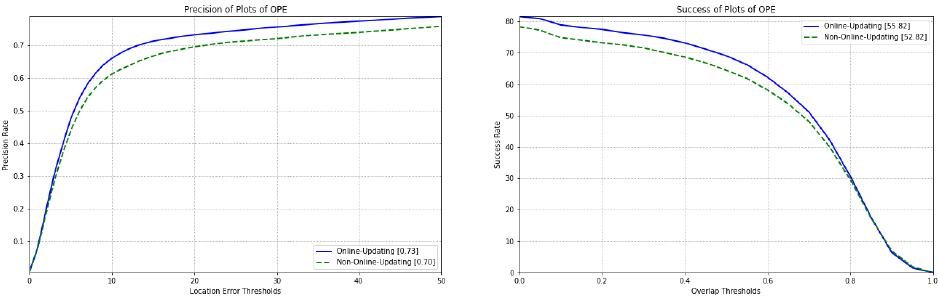
Figure 11. Success and precision plots on OTB2013 dataset with online-updating or non-online-up- dating. Table 4. AOR and APE, as well as speed of online-updating or non-online-updating, on the OTB2013 dataset.